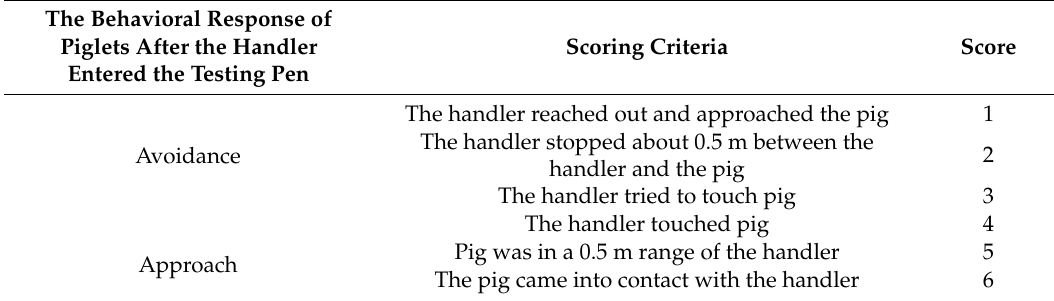
Table 1. Scoring standard for avoidance and approach [9,16].